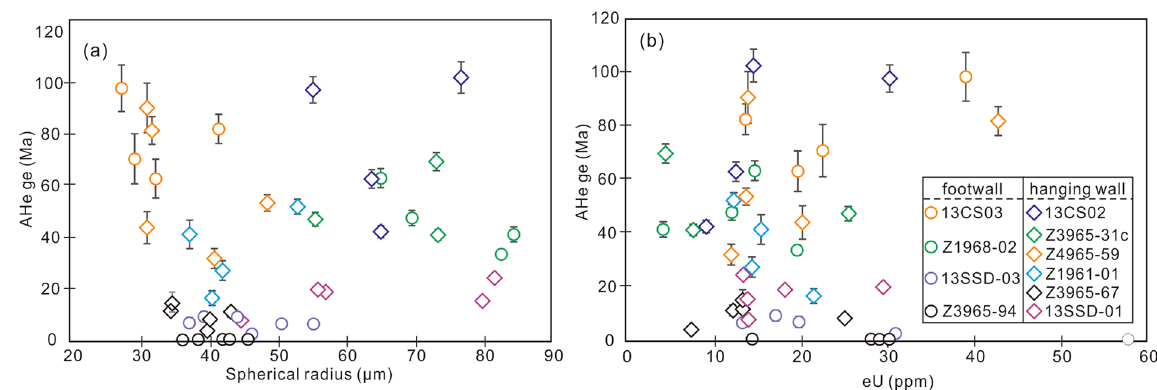
Figure 5. ( a ) A plot of AHe ages versus spherical radius for each grain; ( b ) A plot of AHe ages versus eU concentration (eU = U + 0.235Th). Note that for each sample AHe ages are neither positively related to grain sizes nor eU concentrations. Symbols in ( a ) are the same as in ( b